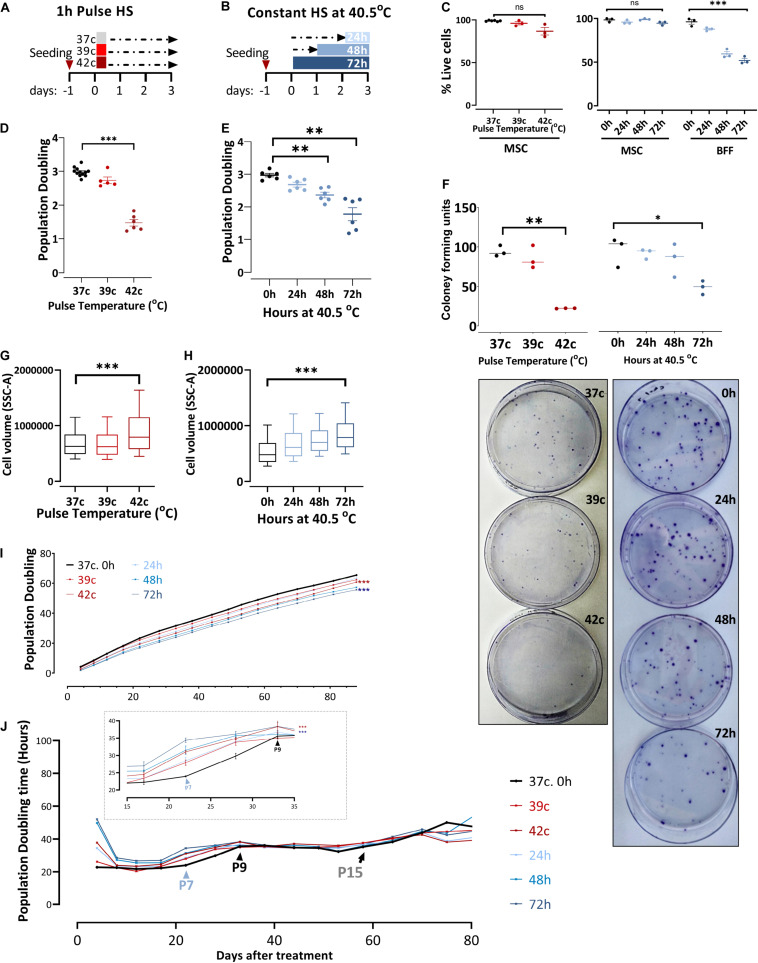
In response to heat shock, bUC-MSCs change their morphology and proliferation rate. (A) Pulse-HS: bUC-MSCs are plated and 24 h later are placed at 39 and 42°C for 1 h and then allowed to recover at 37°C for 3 days. (B) Constant HS: bUC-MSCs are plated and 24 to 72 h later are moved to grow at 40.5°C for 1–3 days. (C) Dead: live MSC ratio as measured using trypan blue does not change dramatically following both HS treatments. In contrast, bovine fetal fibroblast (BFF) shows massive death rates following constant HS treatment. (D) bUC-MSC Population doubling declines following pulse and (E) constant HS. (F) Drop in clonogenicity of cells after pulse or constant HS. Data from C to F are mean ± SEM for n ≥ 3. Unpaired, two-tailed Student t-test was used for comparison of means. ***p < 0.001, **p < 0.01, *p < 0.05, ns = nonsignificant. (G) Side-scatter geo-mean data of cells after pulse and (H) constant HS are shown. One flow analysis of 10,000 cells is shown (representative result, n = 3). (I) Growth curve of untreated cells (black line) and cells after HS. Each line represents a sample, and each time point represents a passage. The mixed-effect model was used for comparison, ***p < 0.001. (J) Population doubling time measured by hours shows the kinetics of proliferation/passage. Immediately after the HS treatment, the cells have nearly ceased to proliferate, but after 1 passage, they narrow the gap with the control cells. Inset shows a narrower window of 20 days between passages 6 and 9. However, the HS cells never completely closed the gap, and even after about 15 passages, all cells are declining toward replicative senescence and cease proliferating. Mixed-effect model was used for comparison, ***p < 0.001.